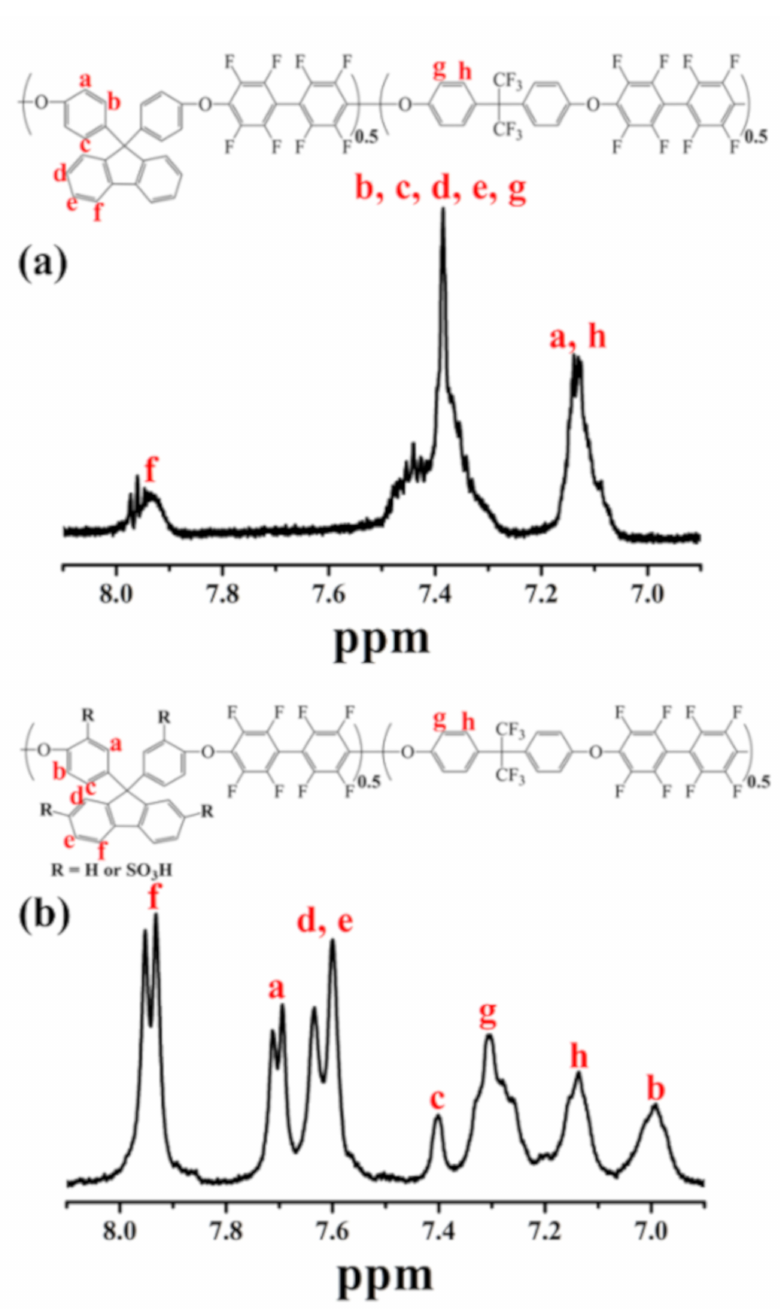
Figure 2. 1 HNMR spectra of ( a ) poly(arylene ether), ( b ) sulfonated poly(arylene ether) in